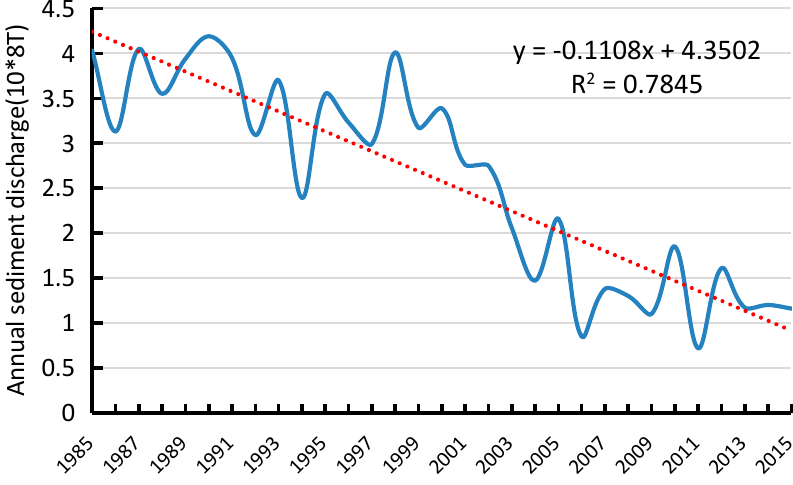
y = -0.1108x + 4.3502 R 2 = 0.7845